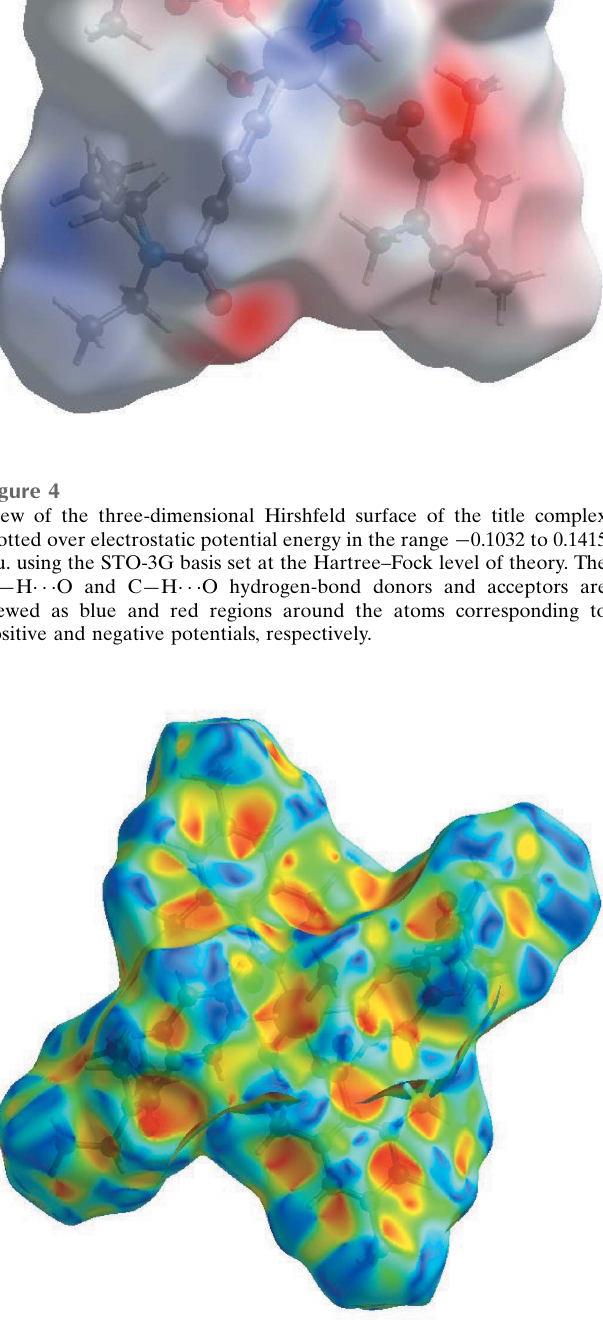
Figure 5 Hirshfeld surface of the title complex plotted over shape-index.